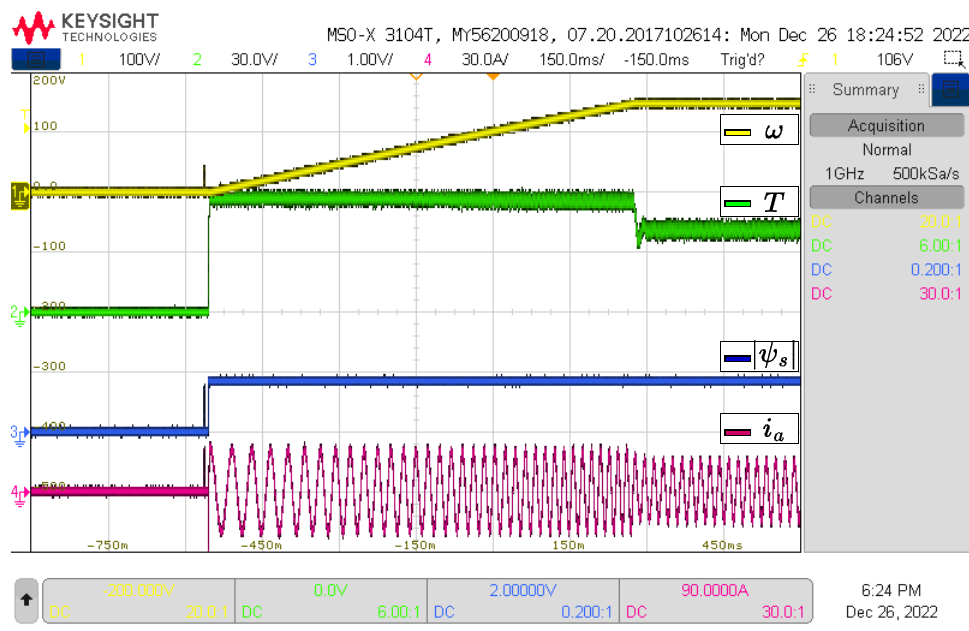
Figure 13. HIL Results for 3L-NPC with N =